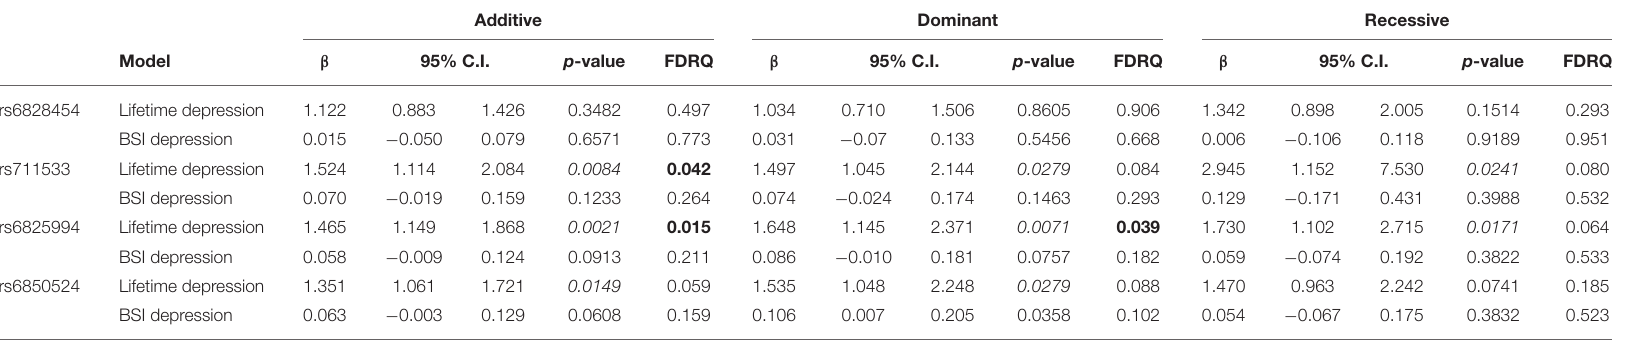
TABLE 2 | Main effects of CLOCK variants emerging as top SNPs in the interaction models on lifetime depression and on current depression (BSI-dep) severity.